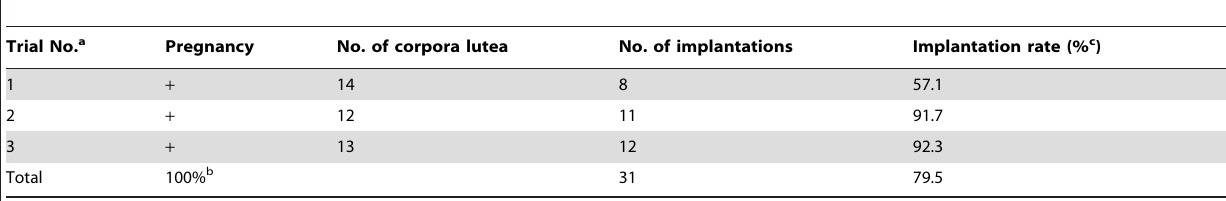
Table 2. Postimplantation development following artificial insemination in